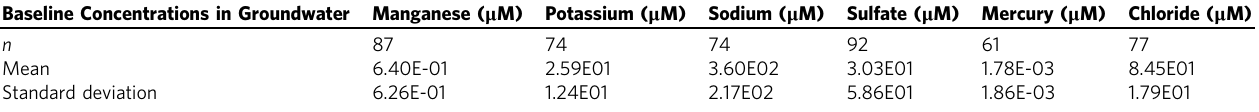
Table 1 Key analytes arithmetic mean and standard deviation ( n = number of